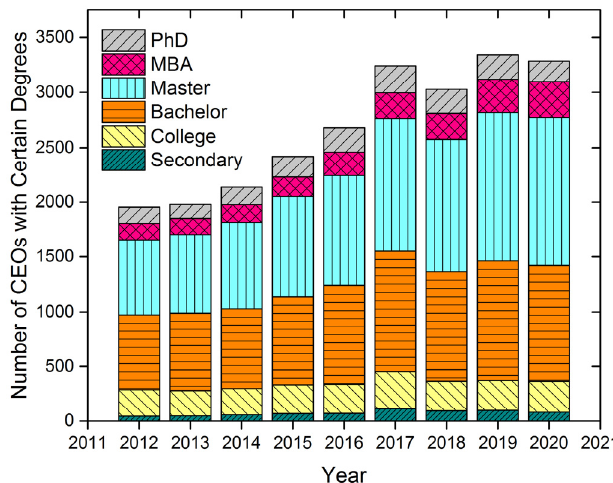
Figure 1. Time trend of the number of CEOs with certain educational degrees. The figure shows the number of CEOs with certain educational degrees from 2012 to 2020 using the CSMAR database.